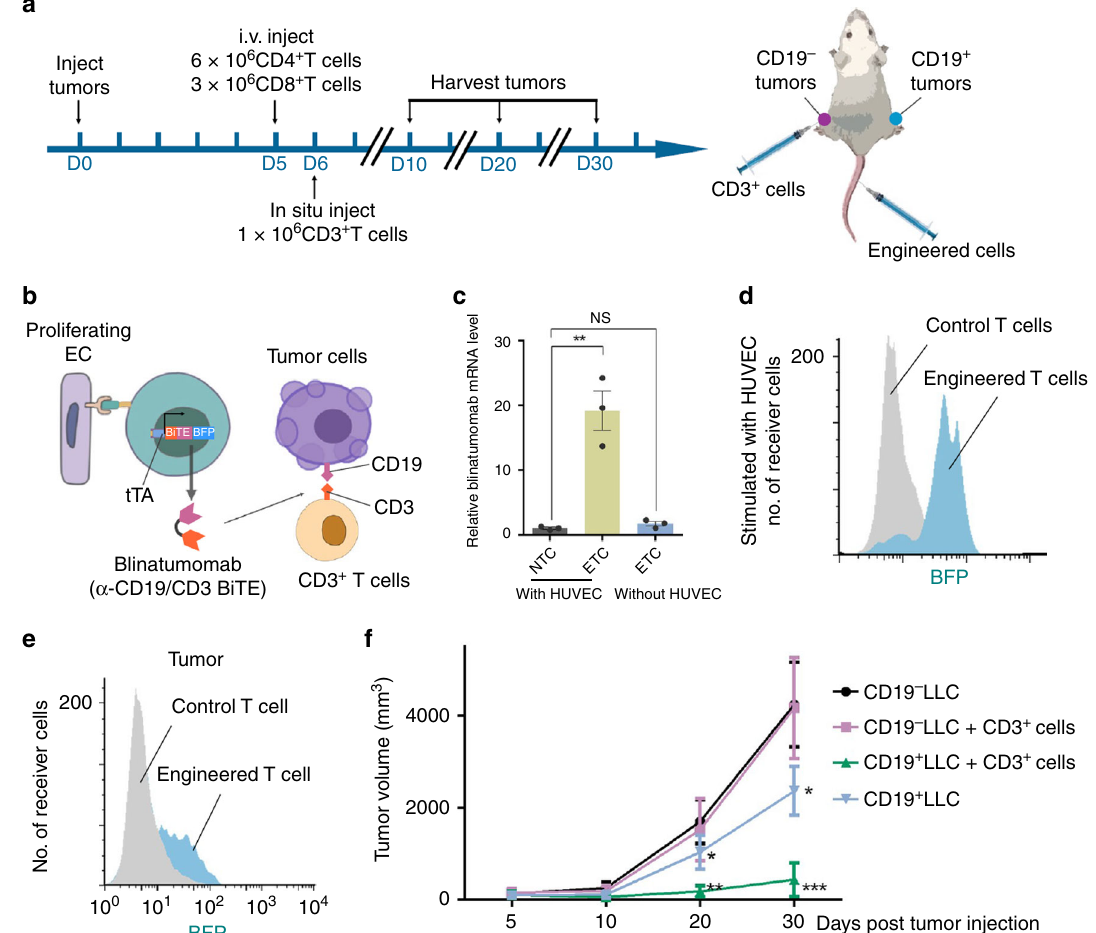
Fig. 7 CD4 + and CD8 + T cells customized with AsNRs can target and inhibit solid tumors. a Schematic showing the experimental strategy for e and f . CD19 + tumor cells were implanted on the right leg and CD19 − tumor cells were implanted on the contralateral leg. The engineered T cells were i.v. injected at D5 and CD3 + T cells were injected into tumors. b Immunotherapy strategy for treating tumors showing that the engineered T cells secreted BFP reporter and blinatumomab ( α -CD19/CD3 BiTE) after they sensed the endothelium of the sprouting vessels, and CD3 + T cells were retargeted to CD19 + tumor cells. c Quantitative analysis results showing the mRNA level of blinatumomab when engineered cells were in direct contact with HUVECs. d Analysis of the BFP + cells by fl ow cytometry after they sensed the HUVECs in vitro. e Analysis of the BFP + cells by fl ow cytometry showing that the T cells engineered with the BiTE system were activated after sensing tumor endothelium. f Tumor growth curves showing that the volume of the tumors was signi fi cantly reduced whether or not CD3 + T cells were injected compared with volume of CD19 tumors, but the reduction was more signi fi cant after the injection of the CD3 + cells. Error bars: SEM. Signi fi cance: *** p < 0.001, ** p < 0.01, * p < 0.05 ( n = 3 in c – e , n = 5 mice for each group in (Miltenyi Biotec, # 130-116-480). T cells were cultivated in RPMI-1640 (Gibco, 8-well cell culture slides (for fl uorescence imaging), and cells were collected after #11875) with 10% fetal bovine serum (FBS; Gibco, #10437), 10nM Sodium Pyr- 24 h culture. For inhibition experiments, adding Bevacizumab (HY-P9906;MEC) to uvate (Gibco, #11360), 2mM L -Glutamine, 100 nM non-essential amino acids the sender cells at 5-day before stimulation. In Supplementary Fig. 7c, receiver cells were planked at the bottom of an eight- (Gibco, #11140), and supplemented with 500 U/ml IL-2 (PeproTech, #212125). well cell culture slide (BD, #354108) and sender cells were planked on coverslips. Flip coverslips onto the bottom of eight-well cell culture slides to coculture receiver Lentiviral production and transduction . Gene of interest was ampli fi ed by PCR cells and sender cells, and coverslips were removed after 24 h for fl uorescence and cloned into lentiviral vector pLenti. Lentivirus was produced via co-transfecting imaging. packaging vector(pLP1/2), envelope vector(pLP/VSVG), and transfer vector(pLenti) in 293T cells. Primary CD4 + and CD8 + T cells were stimulated by Dynabeads ™ Mouse T-Activator CD3/CD28 (cell:bead, 1:3) for 24h, and lentivirus was then Xenograft tumor models . LLC and GL261 cells were cultured in DMEM/F12 added to the medium for 24h. Repeat T-cell transductions per 24h after CD3/CD28 medium containing 10% FBS, 100 U/ml penicillin, 0.1mg/ml streptomycin, and activation. Dynabeads were removed at day 5 post T-cell stimulation. The other cells, including U251, HEK293, primary NSPCs, primary fi broblasts, and primary astrocytes, were all exposed to lentivirus for 24h. Recombinant DNA used were as respectively 33 . For glioma models 51 , 1× 10 5 CD19 − and CD19 + GL261 cells were follows: pLenti-EF1a-EGFP-P2A-Puro (Obio Technology, ID# HYKY-180322019- injected stereotactically into brain (injection site: bregma, 2mm to the right of the DLV), pLenti-EF1a-EGFP-P2A-Puro-CMV-AsNC-3Flag, pLenti-EF1a-EGFP-P2A- sagittal suture, 3 mm depth). On day 5 after xenograft tumors, T cells were injected Puro-CMV-AsNT, pLenti-EF1a-P2A-Puro- CMV-CD19 13 , tetO-RFP-Ubi-puro through the tail vein (i.v.). T cells were suspended in phosphate-buffered saline (Shanghai Genechem, ID# GOSL0186876), Ubi- Apj -RNAi-SV40-puro 22 , tetO-Bli- (PBS) for all injections. CD4 + and CD8 + engineered T cells were injected at a natumomab-IRES-BFP-SV40-puro (www.drugbank.ca/drugs/DB09052). ratio of 2 :1. For the i.v. injection, a total of 9× 10 6 T cells were injected and 5 ×10 5 CD3 + T cells were injected into the tumor on the sixth day according to the In-vitro stimulation of AsNRs cells . AsNR cells and bEnd.3 cells/HUVECs were experimental requirements. In experiments requiring fl ow cytometry, tumors were collected into RPMI supplemented with 1% FBS (Gibco) on day 7 or day 21 post cocultured at a ratio of 1:1 in 12-well cell culture plates (for fl ow cytometry) or